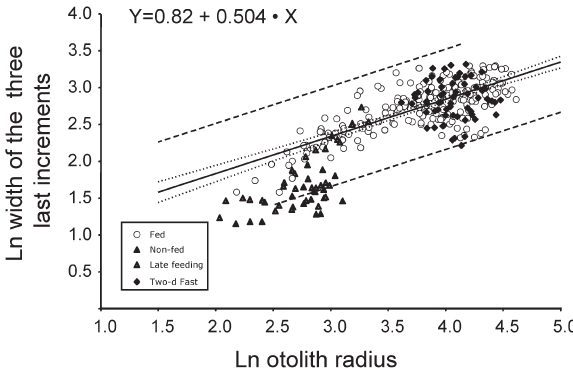
Fig . 5. – relationship of the otolith radius (µm) vs. the width of the three outermost complete growth increments (µm) for the fed larvae (solid line, ln-transformed units). Broken lines: 95-% confidence interval (ci) for the mean (inner ci) and observations (outer ci). the data from the other treatments are superimposed but are not used for the regression.